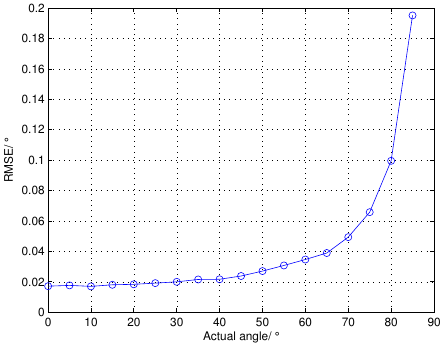
Figure 8. The root mean square error (RMSE) of CCAE in different target